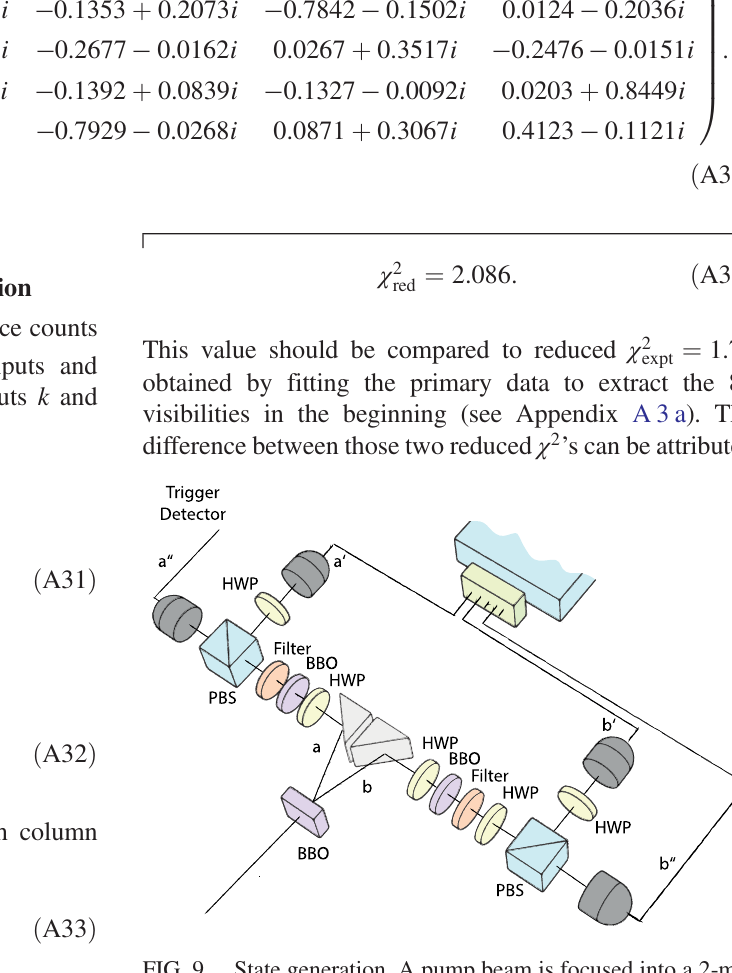
FIG. 9. State generation. A pump beam is focused into a 2-mm β -BaB 2 O 2 crystal cut for noncollinear, degenerate, type-II down- conversion. The generated state is emitted into the spatial modes a and b . A compensation scheme consisting of half-wave plates and 1-mm-thick BBO crystals is applied for countering temporal and spatial walk-off. Narrow band interference filters 3 nm) are applied to increase the temporal coherence ( λ FWHM ¼ of the photons and render them close to spectral indistinguish- ability. The modes a and b are subsequently split by polarizing beam splitter cubes and two half-wave plates in their reflected ports are set to 45° to ensure the same polarization in all four output modes ( a 00 , a 0 , b 0 , and b 00 ). With this scheme, three indistinguishable photons in modes a 0 , b 0 , and b 00 each can be heralded from a fourfold emission by a successful trigger event in mode a 00